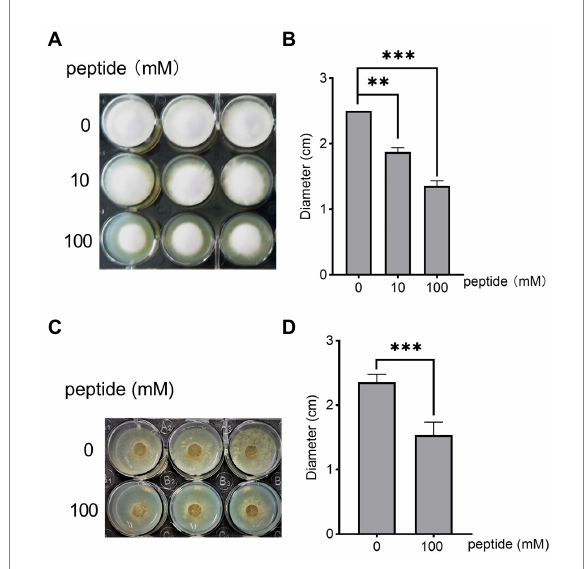
FIGURE 5 The peptide His-Ala-Phe-Lys (Hafk) antagonizes Fusarium oxysporum and Botrytis cinerea . (A) Growth inhibition assay of Hafk peptide against F. oxysporum . Different concentrations of Hafk peptide (50 μ l) were evenly spread on the surface of the agar media in a 12-well-plate (diameter of each well, 25 mm), and then a fungal disk (diameter, 5 mm) was placed in the center of each well and cultured at 28 ° C. Images were taken 3 days after placement. A representative image is presented. (B) Hafk peptide inhibited the growth of F. oxysporum , as evidenced by the diameter of fungal mycelial growth. Data are presented as mean ± SD ( n = 3). Asterisks indicate significant differences with or without the addition of the peptide (** p < 0.01, *** p < 0.001, Student’s t -test). The experiments were repeated with similar results. (C) Growth inhibition assay of Hafk peptide against Botrytis cinerea . The experimental conditions were the same as those in (A) , except that B. cinerea was used. (D) Hafk peptide inhibited the growth of B. cinerea , as evidenced by the